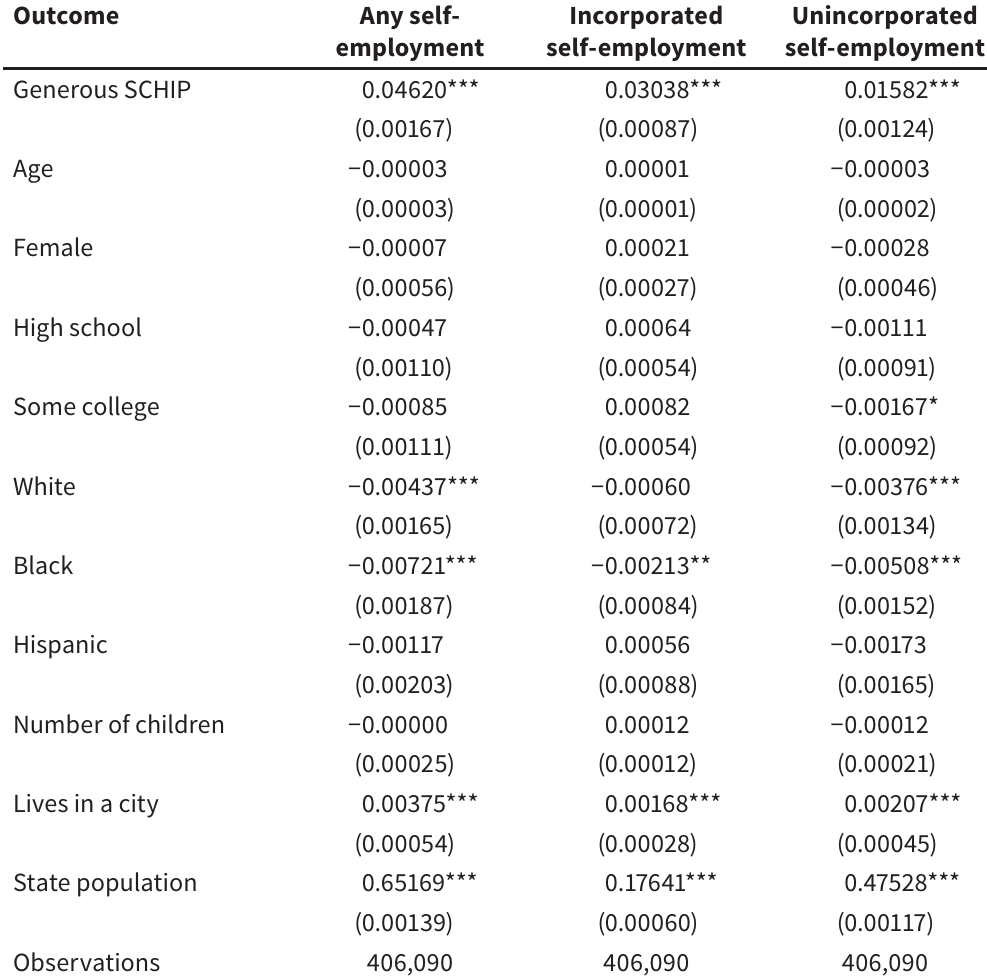
Table A9 Heterogeneity in the Impact of Immigrant Entrepreneurs across Skill Levels of Natives: First Stage Estimates for Low